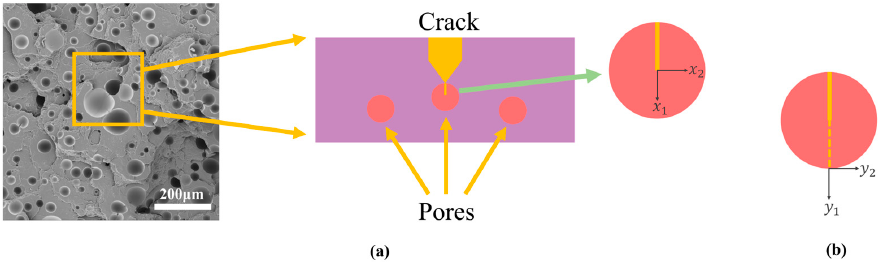
Figure 11. ( a ) The SEM specimen and the pore termination of the primary crack; and ( b ) the stretched single pore.